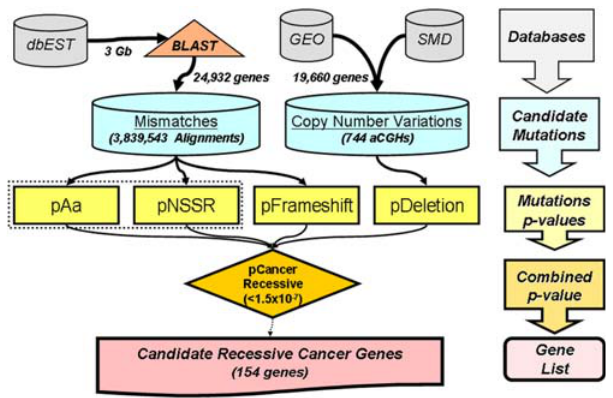
Figure 1. The rationale for selection of candidate recessive cancer genes. The diagram shows the steps in the procedure for the evaluation of mutation probabilities and the data flow towards the identification of candidate recessive cancer genes. Molecular data were extracted from public databases (dbEST and GEO at NCBI, and Stanford Microarray Database). A very large number of alignments (over 4.5 million) was obtained for over 24,000 human genes from BLAST analysis of 3 Gbases of EST sequences. The alignments were parsed to extract mismatches which were deposited in the Cancer Mutome local SQL database. The mismatches were then evaluated by specific procedures to associate mutational p-values to each human gene. In parallel, almost 20,000 human genes were assayed from 744 array CGH to define their propensity to deletion in cancer. The specific mutational p-values were combined to produce a recessive cancer p-value. A genome subset of 154 genes, among which TP53 , PTEN , CDKN2A and CDKN2B were present, was selected (cancer p-value , 1.5 6 10 2 7